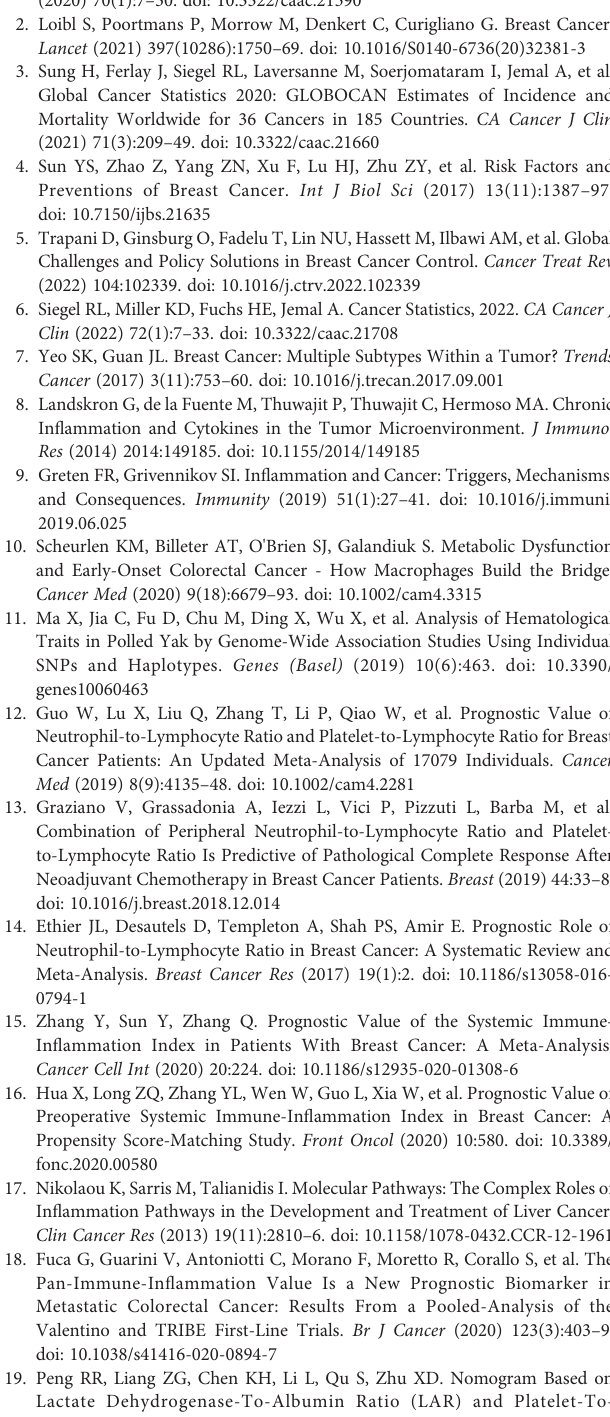
Supplementary Figure 6 | Time-dependent ROC curve compared with PIV and (A) NLR, (B) PLR, (C)